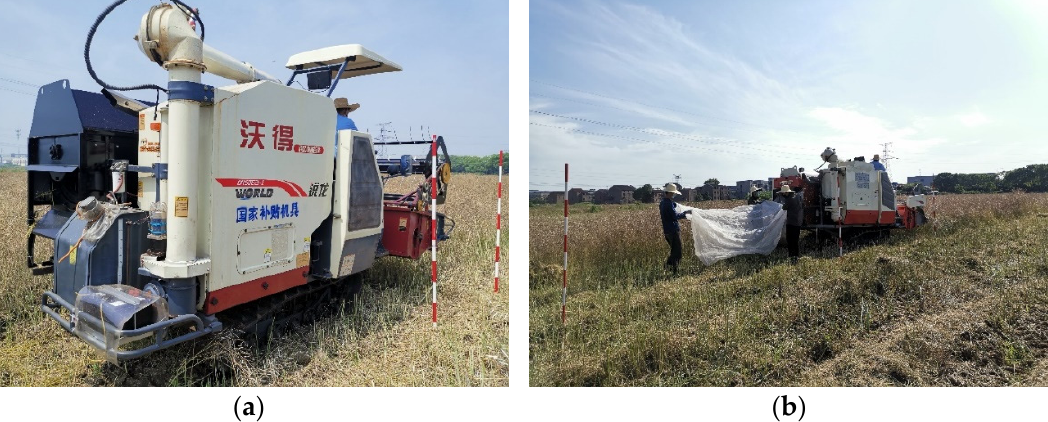
Figure 6. Oilseed rape harvest. ( a ) World oilseed rape combine harvester. ( b ) Test Sample collection.